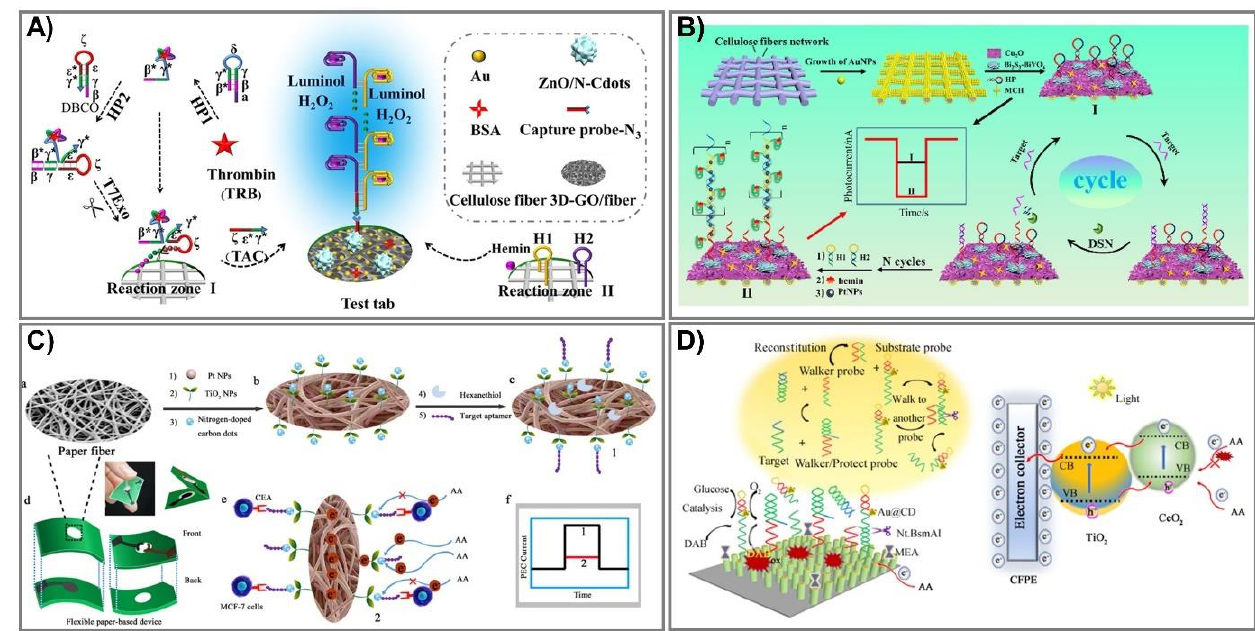
Figure 7. Photoelectrochemical paper-based analytical devices. ( A ) The intrinsic light Au@3D-rGO/cellulose sensor generates a photocurrent signal to detect protein in clinical biomedicine. Adapted with permission from Ref. [142]. ( B ) The construction process and mechanism for cathode PEC PADs shown to detect microRNA-141 by duplex-specific-nuclease (DSN) connection. Adapted with permission from Ref. [143]. ( C ) The PEC TiO 2 –Pt/PWE biosensor was fabricated by modification of paper with N-carbon dots/TiO 2 –Pt with a seed-mediated growth method to detect carcinoembryonic antigen (CEA). (a–c) preparation of photoelectrochemical biosensor, (d) diagram of paper-based platform, (e) detection mechanism, (f) photocurrent intensity with/without CEA. Adapted with permission from Ref. [144]. ( D ) An ultrasensitive PEC paper-based device to determine miRNA-141 from a two-enzyme-engineered DNA walker and a TiO 2 /CeO 2 heterojunction. Adapted with permission from Ref. [128] .